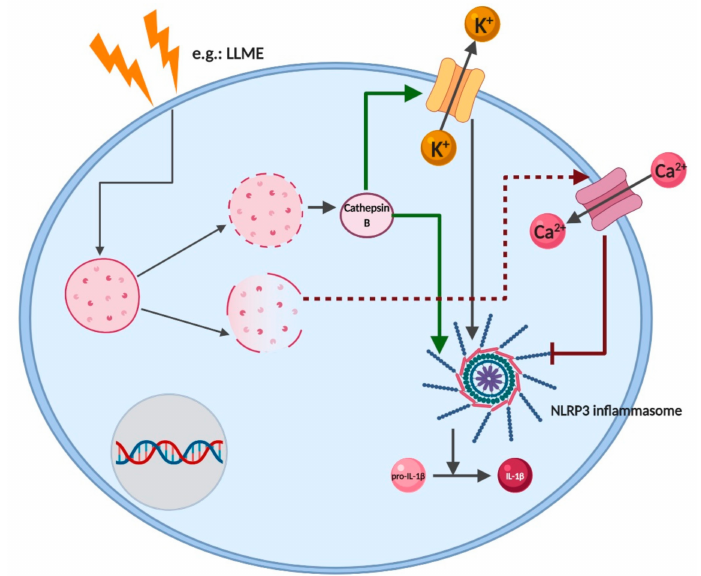
Figure 6. NLRP3 inflammasome activation via cathepsins release. Particulate matter, such as asbestos, are phagocytosed and induce physical destabilization of lysosomal membranes. Slow and partial lysosomal disruption (green arrow) leads to controlled cathepsin B leakage and correlates with K + e ffl ux and robust NLRP3 inflammasome activation. In contrast, an extremely rapid and complete collapse of lysosome integrity (red arrow) correlates with attenuated NLRP3 activation, Ca 2 + influx and caspase-1-independent necrotic cell death. LLME, Leu-Leu-o-Methyl Ester. Created with